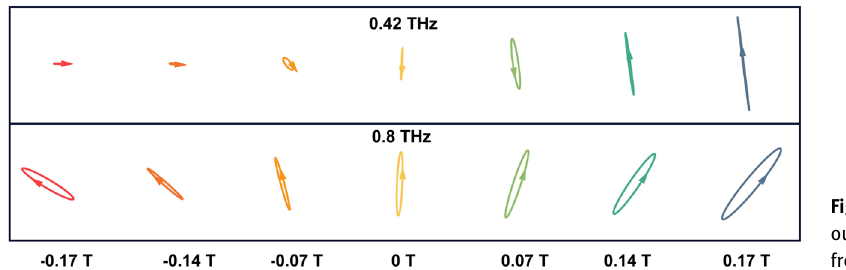
Figure 4: The polarization ellipse for the output wave for different MFs and frequencies.